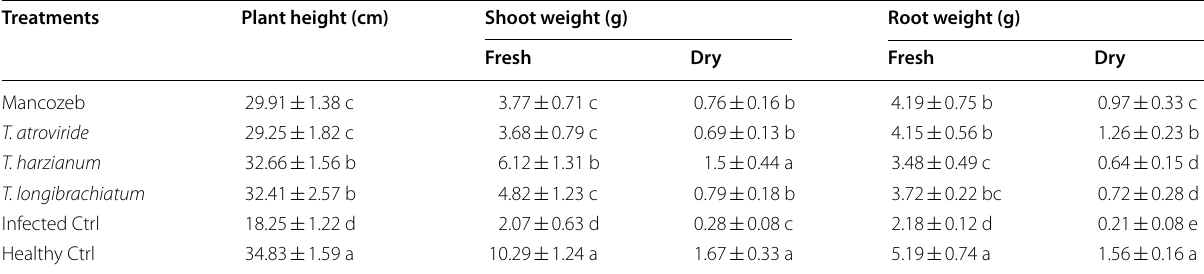
Table 1 Effect of bioagents on growth parameters of tomato plants after inoculation with Alternaria solani under greenhouse conditions